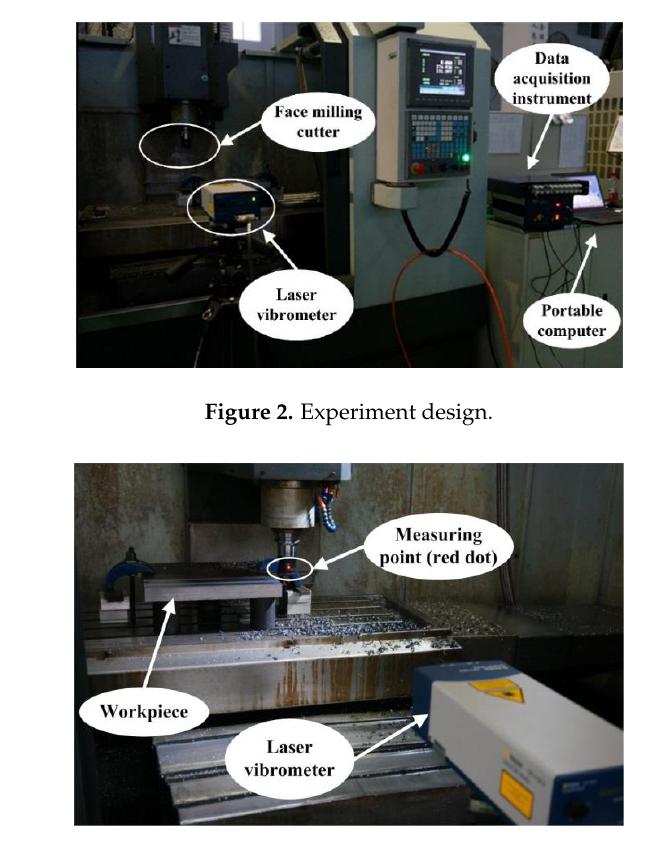
Figure 3. Measuring vibration signal by a laser vibrometer.